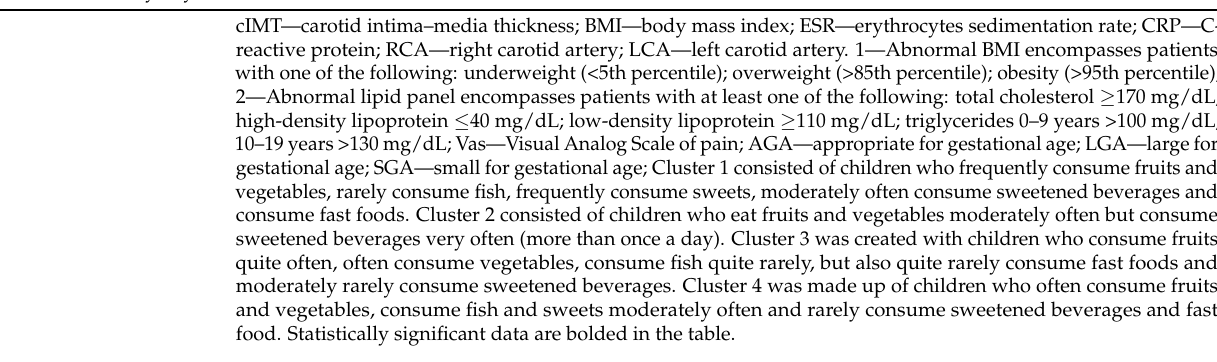
Table 5. Relationships between selected parameters and diet-related